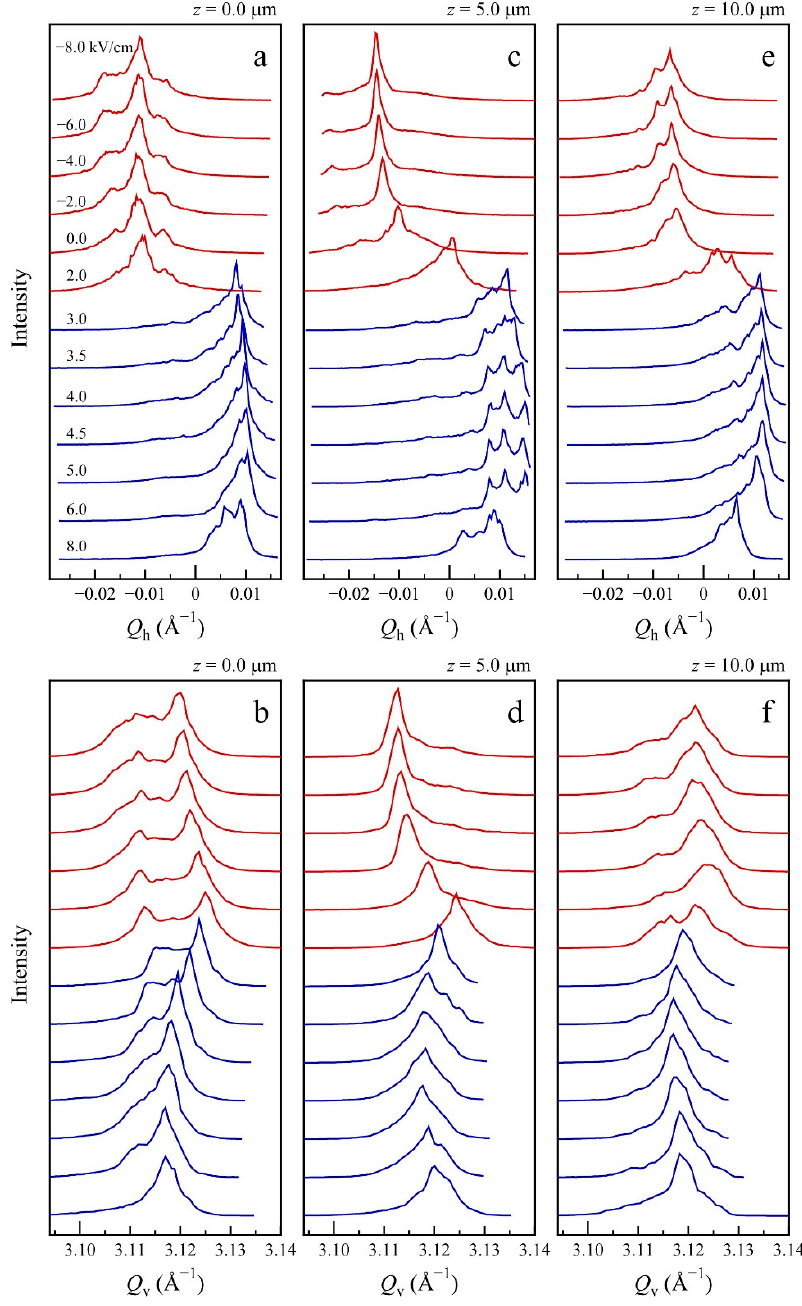
Figure 6. DC field dependences of Q h and Q v one-dimensional profiles of the 002 Bragg peak through the intensity maxima at z = ( a , b ) 0.0, ( c , d ) 5.0, and ( e , f ) 10.0 µ m in the nanobeam XRD for local structure under DC field. Profiles before and after polarization switching are colored in red and blue, respectively.